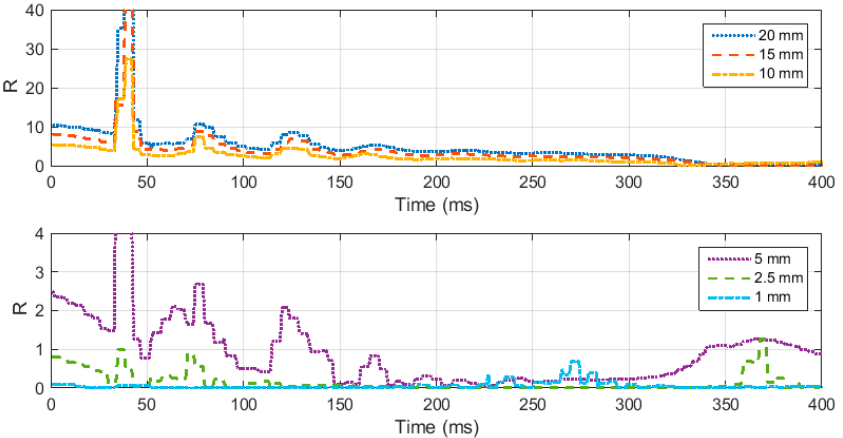
Figure 5. ( a ) Ratio “R” for specimen diameter 20 mm and thickness 20 mm, 15 mm, and 10 mm. ( b ) Ratio “R” for specimen diameter 20 mm and thickness 5 mm, 2.5 mm, and 1 mm.